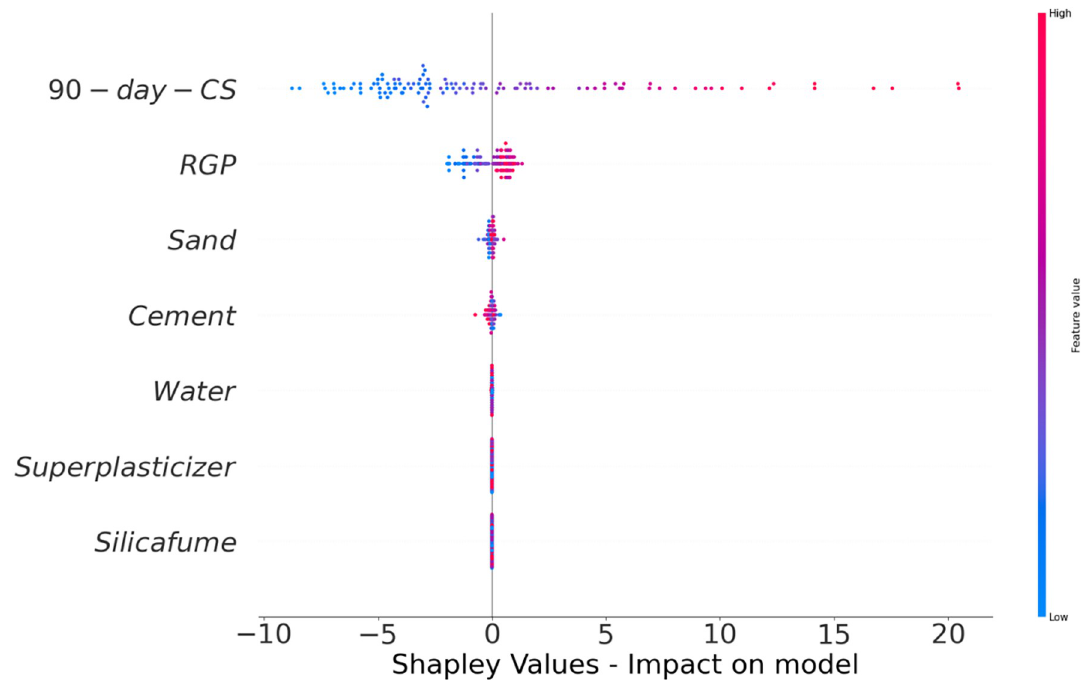
Fig 18. Relevance of raw components on the CS after the acid